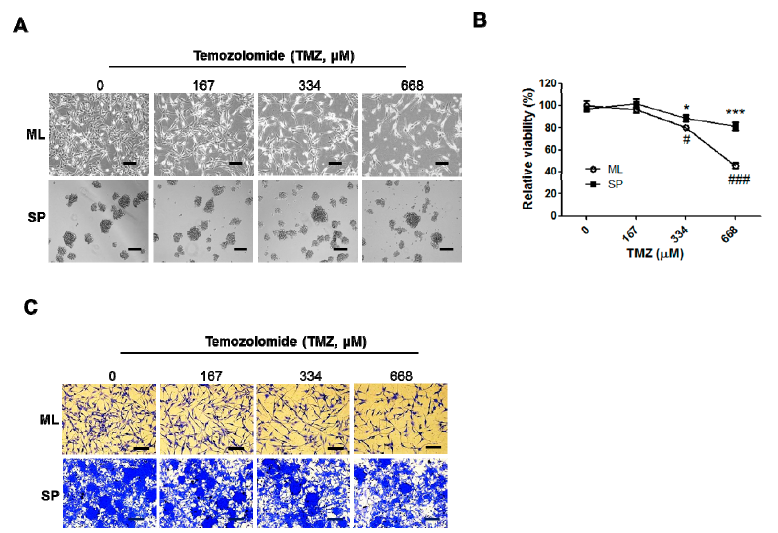
Figure 4. Temozolomide (TMZ)-induced cell death in the ML and SP-forming conditions. Following TMZ treatment for 48 h in the ML or SP-forming conditions, cellular images were taken with an inverted microscope ( A ) and the chemosensitivity was measured using a viability assay kit as described in Materials and Methods ( B ); ( C ) Crystal violet staining was performed after treatment of increasing dose of TMZ for A172 cells in ML and SP-forming conditions. Spheres were re-attached on L -ornithine-coated plates. * p < 0.05 and *** p < 0.005 vs. 0 μ M TMZ-treated ML, # p < 0.05, ### p < 0.05 vs. 0 μ M TMZ-treated SP. Scale bars: 200 μ m.